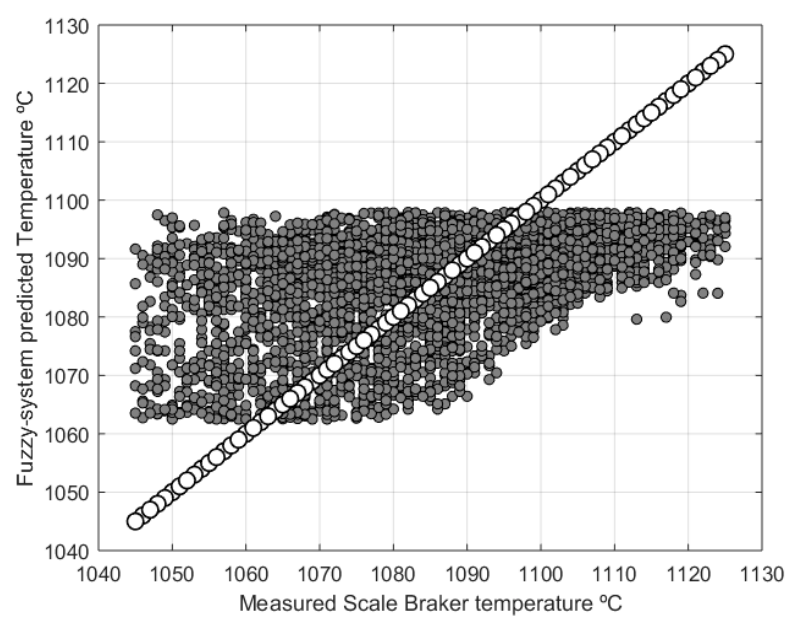
Figure 11. Scatter diagram of the 9-rule HL type-2 Sugeno purely fuzzy system predicted scale breaker entry temperature.